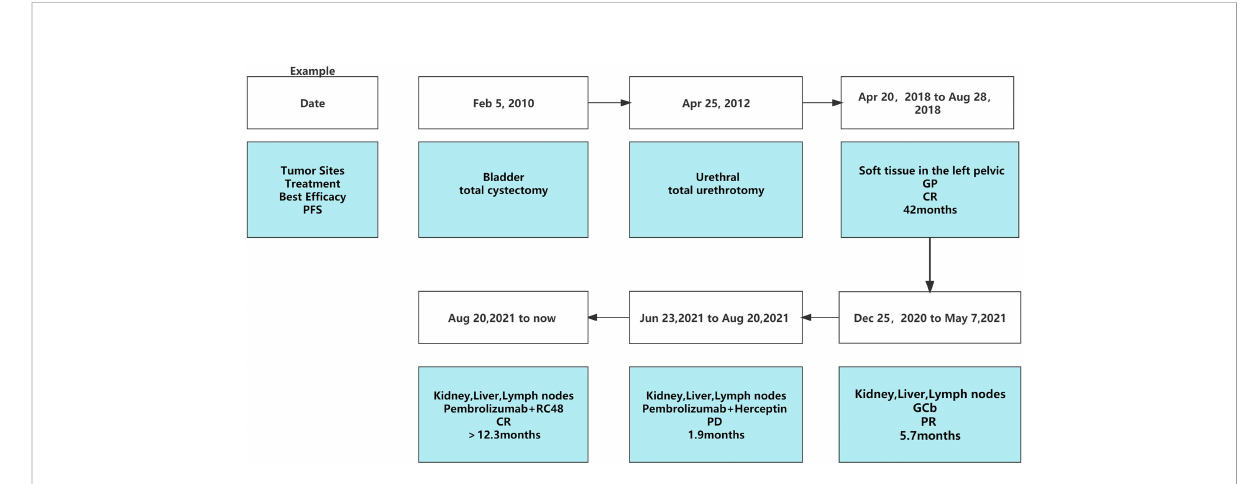
FIGURE 3 Timeline scheme of the major clinical events of the